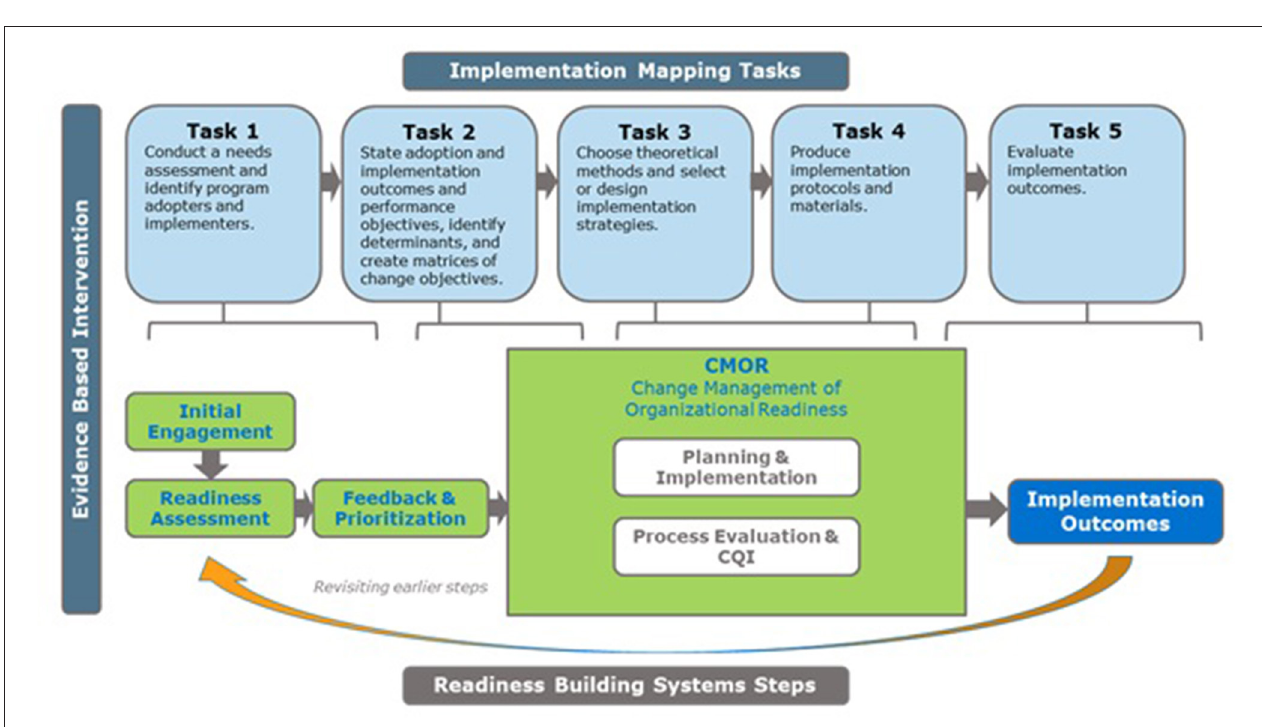
FIGURE 3 | Implementation mapping and readiness building system